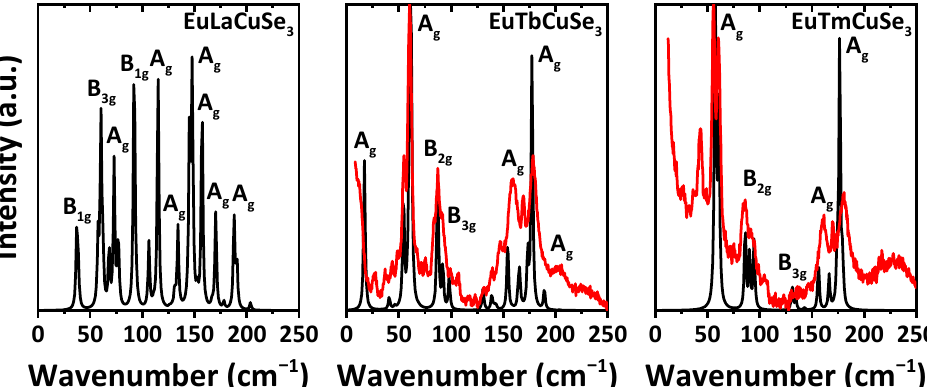
Figure 7. The calculate (black) and experimental (red) Raman spectra for the selected selenides of three different structural types. Calculations were performed at λ exc = 514.5 nm and T = 300 K for EuLaCuSe 3 , and for λ exc = 532 nm and T = 296 K for EuTbCuSe 3 ( Pnma ) and EuTmCuSe 3 ( Cmcm ), respectively. The wavenumber scale of the calculated spectra was multiplied by 0.9 to compensate the overestimated results obtained by the applied PBE0 functional.